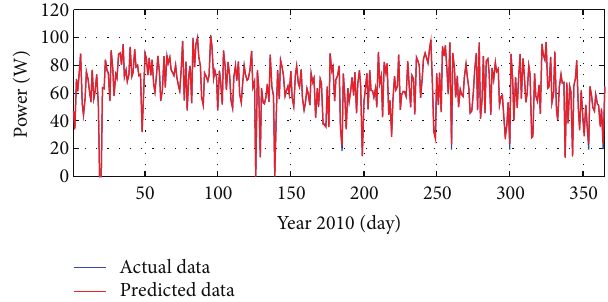
Figure 8: Results for real data and FFBP for 2010 with 6 hidden neurons and 1000 epochs.